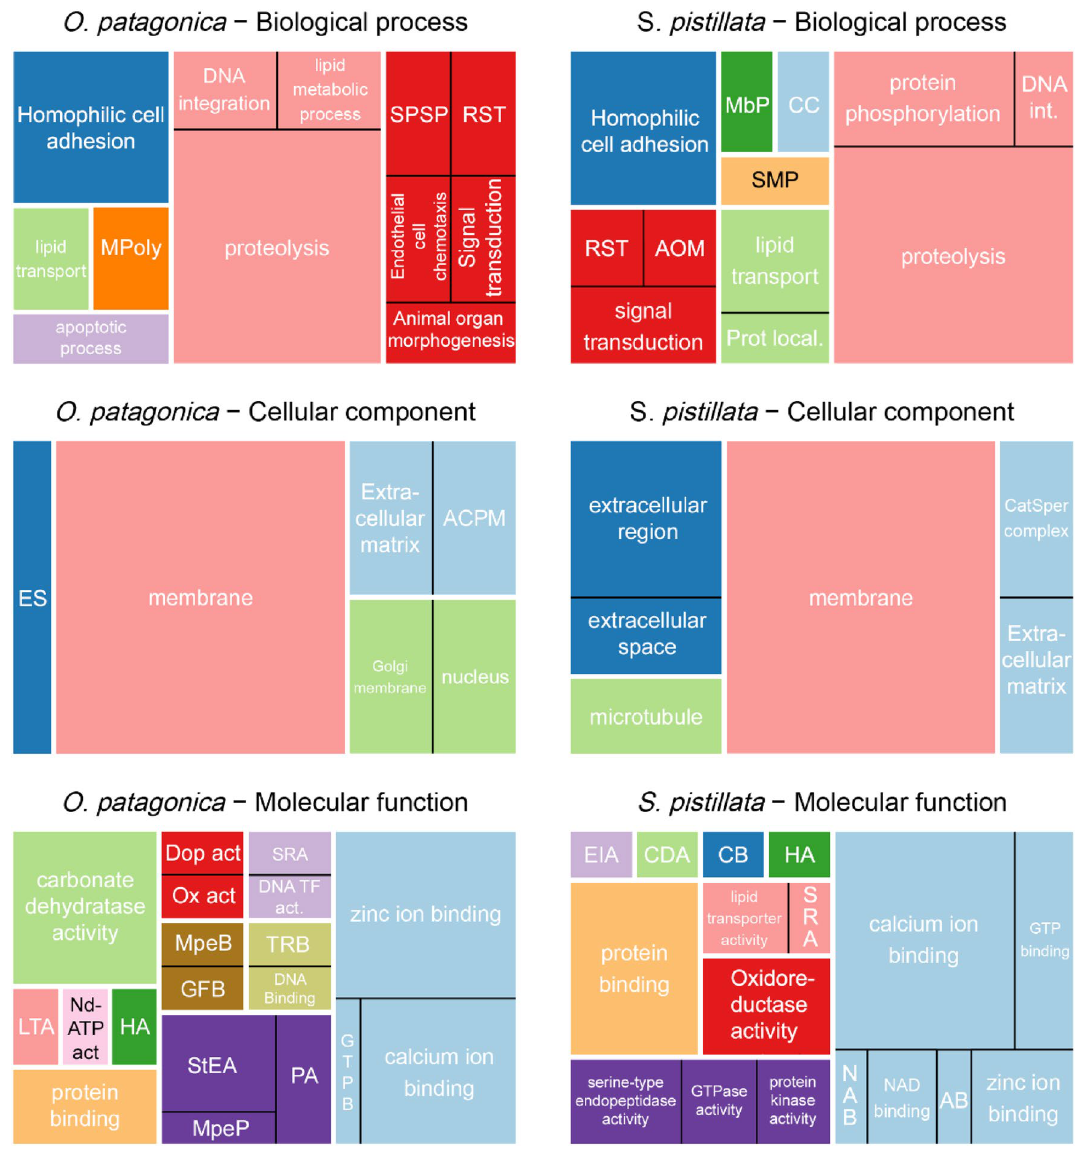
Figure 2. Comparison of GO term lists visualized as a treemap. Each rectangle is a single cluster representative. The representatives are joined into "superclusters" of loosely related terms, visualized with different colors. The rectangles’ sizes were adjusted to reflect the frequency of representation for each species of the GO term. Abbreviations and cluster information can be found in Table